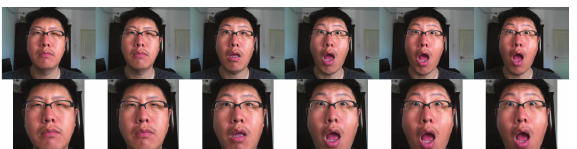
Figure 4: Comparing of the original images and the images after alignment.